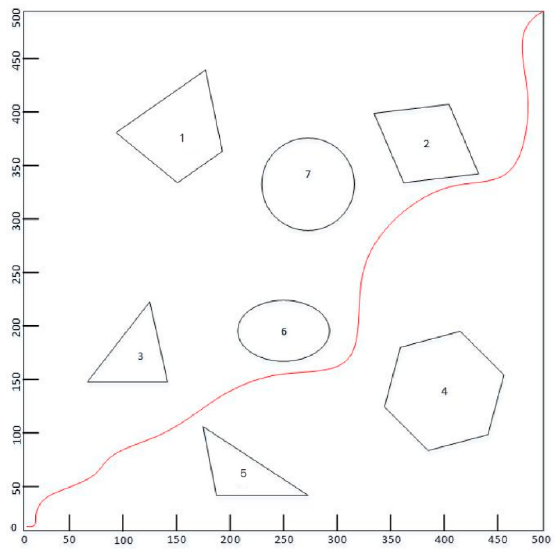
Figure 26. Emulation experiment of collision detection.